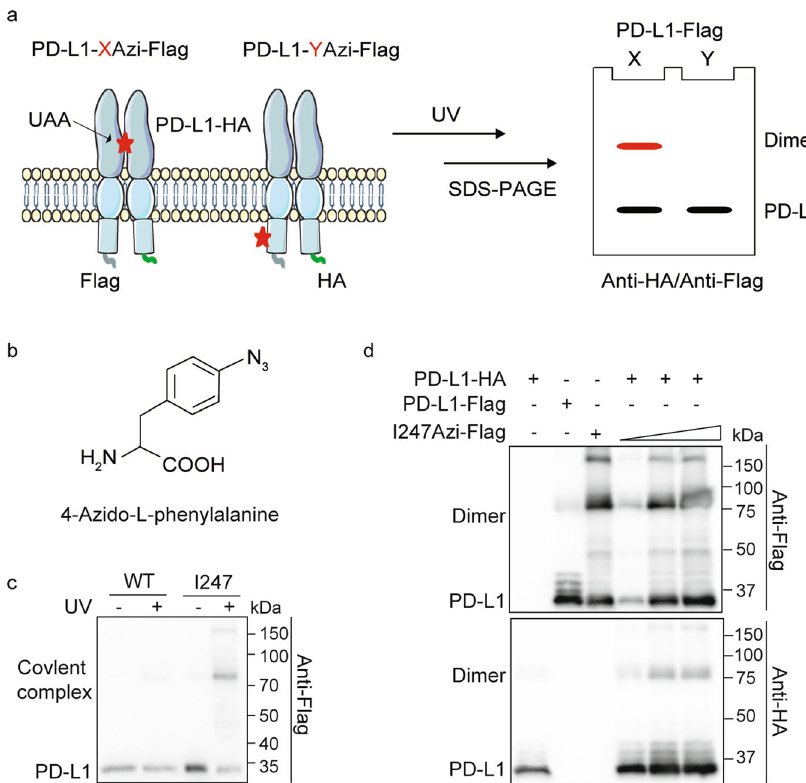
Fig. 1 PD-L1 homodimerized in living cells. a Schematic diagram of genetically incorporated photocross-linking UAAs covalent capture PD-L1 homodimer. UAAs incorporated positions were referred with X or Y . PD-L1-X/YAzi-Flag, and WT PD-L1-HA were coexpressed in living cells. The anti-HA positive cross-linking band (colored red) is the complex of PD-L1-HA captured by PD-L1-XAzi-Flag. Red stars indicated the incorporated UAAs. Green curves indicated the HA tag and light blue curves indicated the Flag tag. b Structural formula of the 4-Azido- L -phenylalanine (Azi). c , d PD-L1-I247Azi captures homodimer dependent on the UAA incorporation and UV treatment. c Cells expressing PD-L1-I247Azi capture cross-linking bands in correspondence to PD-L1 homodimer. HEK293T cells were transiently transfected with PD-L1-I247tag-Flag and pIRE4-Azi plasmids. 1 mM of Azi was added to the medium. Cell lysates were separated on SDS-PAGE gels. Immunoblotting was performed using anti-Flag antibodies. d HEK293T cells were cotransfected with PD-L1- I247tag-Flag, pIRE4-Azi and PD-L1-HA plasmids. The quantity of PD-L1-I247tag-Flag plasmid increased from lane 4 to lane 6. All samples were treated with PNGase F to remove the